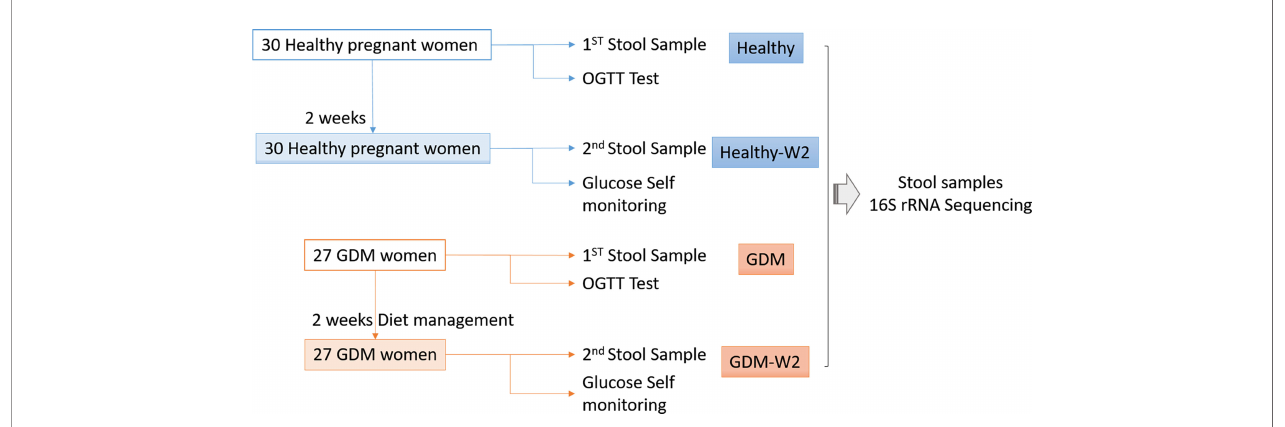
FIGURE 1 | Flow chart illustrating the recruitment of GDM and